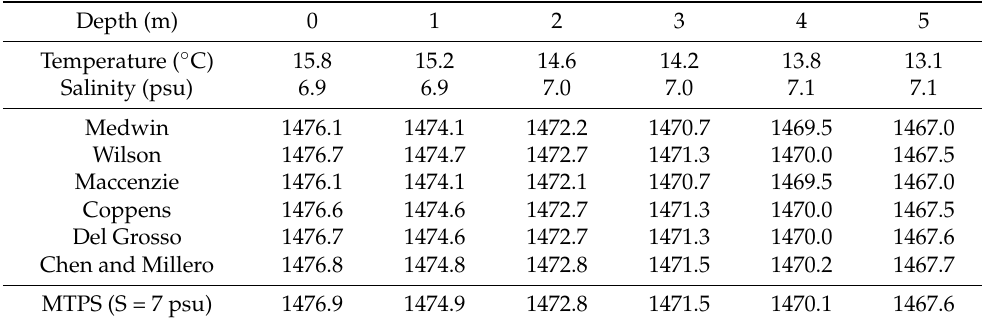
Table 9. Sound speed in water determined using selected formulas.